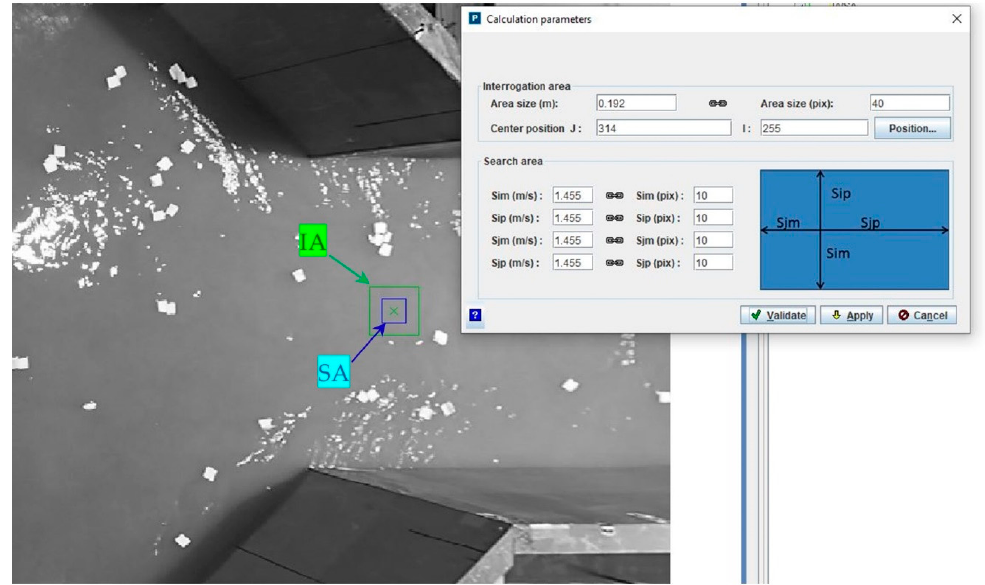
Figure 6. Delineation of the search area (SA) and the interrogation area (IA).